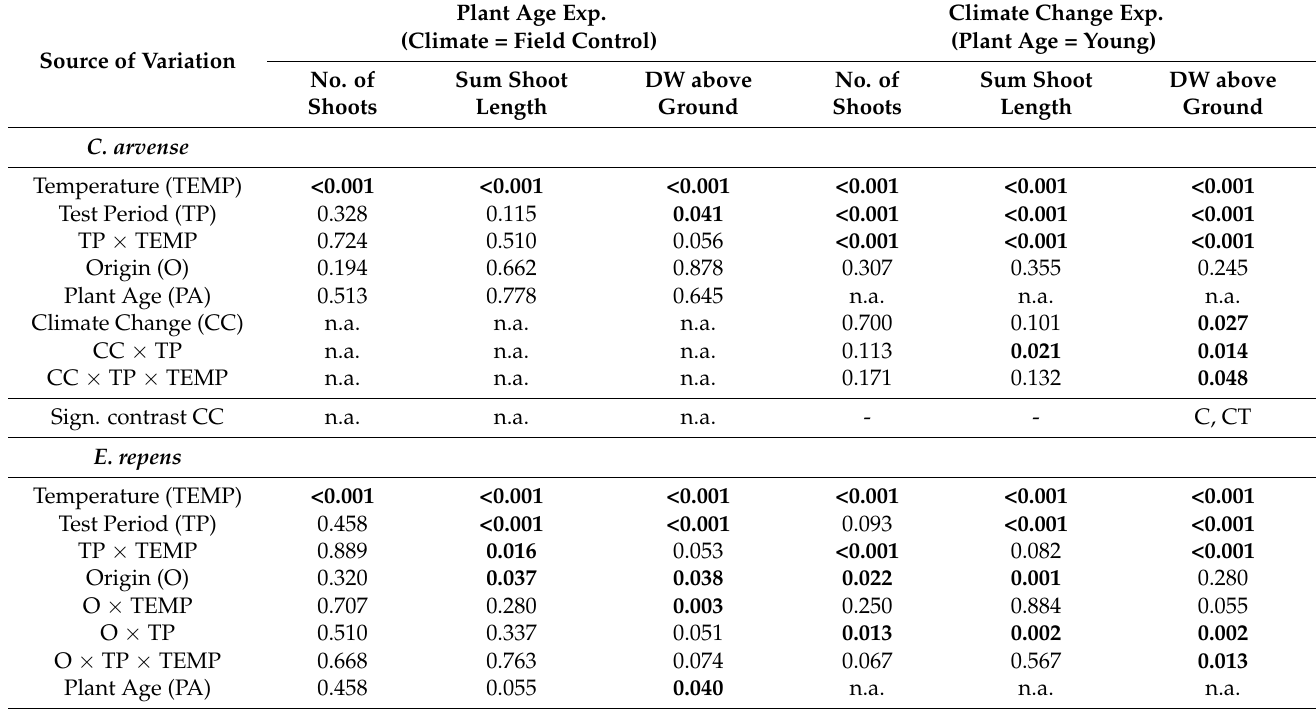
Table 1. Results of the ANOVA for Cirsium arvense (L.) Scop. and Elymus repens (L.) Gould. No analyses on Sonchus arvensis L. are shown because this species did not produce any sprouts. Non- significant interactions are not shown. Significant effects ( p ≤ 0.05) are in bold. The contrasts C (main effect of elevated CO 2 ) and CT (interaction CO 2 x temperature) are explained in the